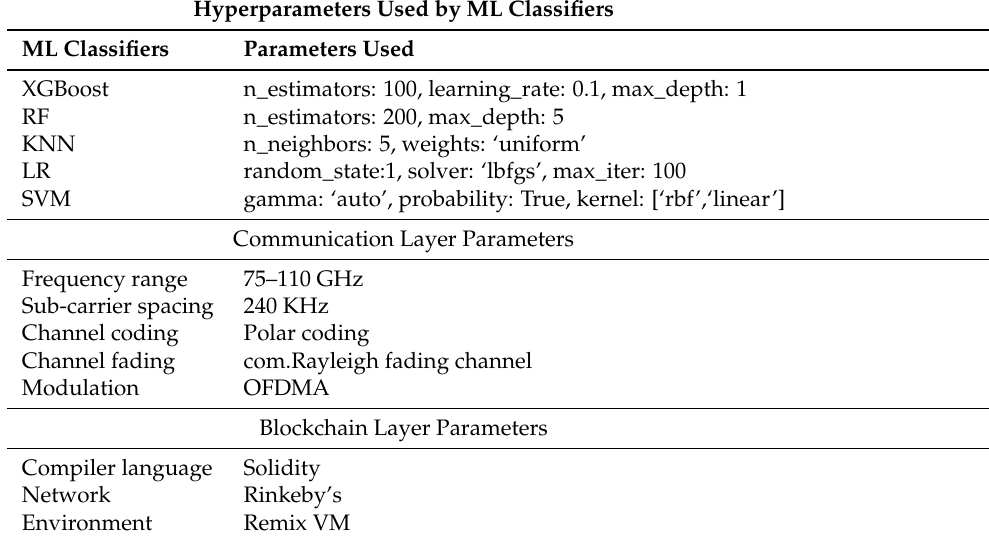
Table 3. Parameters of the proposed